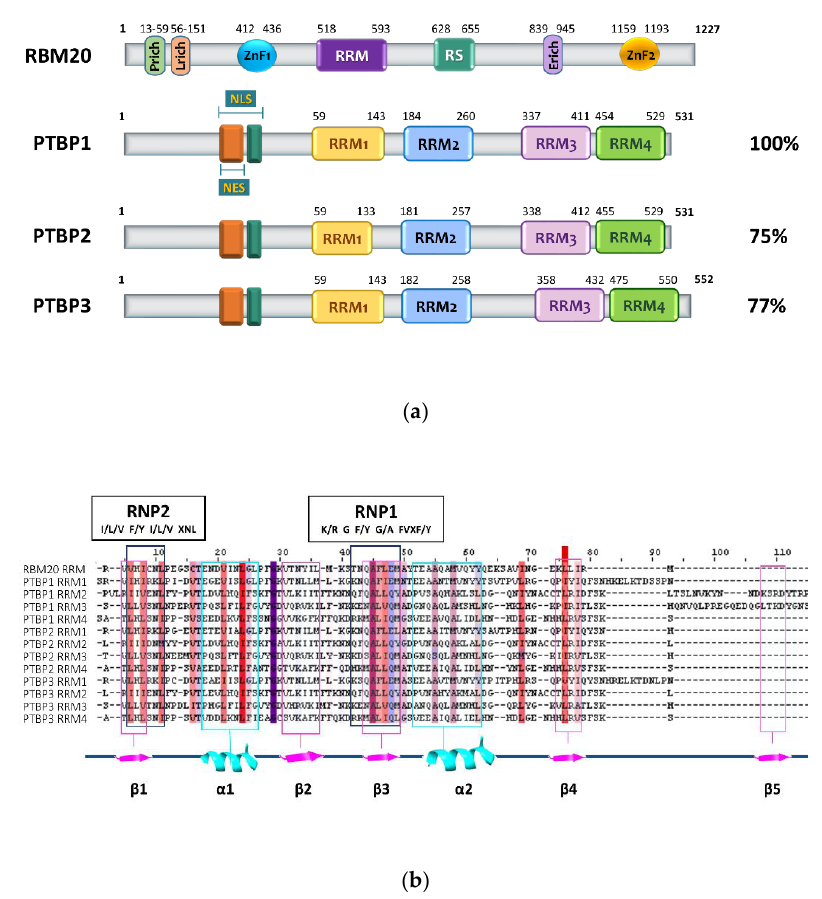
Figure 1. Schematic representation of the RBM20 and PTBP protein structures and multi-alignment of the RRM domains. ( A ) Numbers indicate the position of the amino acid residues relative to the protein domains. E-rich, glutamate-rich region; L-rich, leucine-rich region; P-rich, proline-rich region. RS, arginine/serine-rich region; ZnF1-2, zinc finger domains; NLS, nuclear localization signal; NES, nuclear export signal; RRM1 to 4, RNA-recognition motif domains. Percentage of homology of PTBP proteins is indicated relative to PTBP1. ( B ) Structure-based sequence alignment of the PTBP and RBM20 RRM domains. The alignment was performed by Clustal Omega analysis and edited using Jalview software [37]. Secondary structure elements predicted by the JPRED tool are indicated below the alignment. The RNA-binding domain cores, RNP1and RNP2, are indicated.